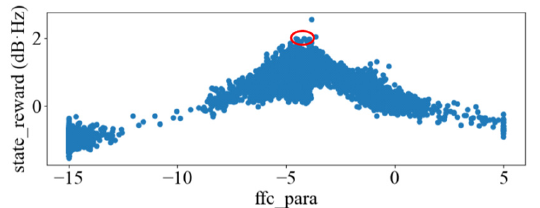
Figure 10. Scatter diagram of state reward and feed-forward proportional parameter. As shown in Figure 11, the FFC proportional control parameter is fixed to − 4.5, and the